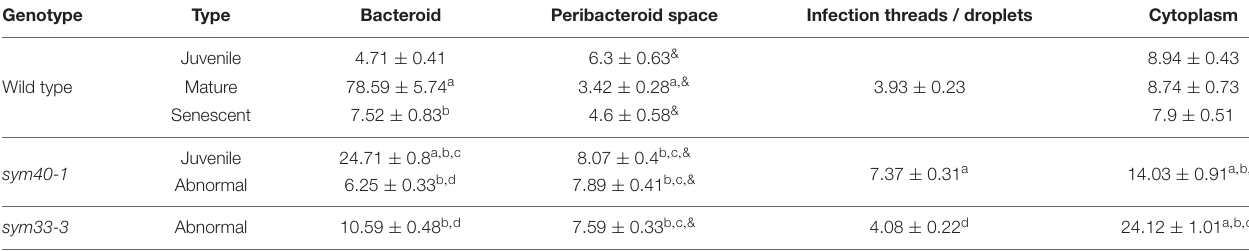
FIGURE 4 | Immunogold localization of glutathione in symbiosomes of nodules from 2-week-old wild-type and mutant ( sym40-1 and sym33-3 ) pea ( Pisum sativum ) plants. (A–C) Wild type; (D,E) sym40-1 ; (F) sym33-3 ; (A,D) juvenile symbiosomes; (B) mature symbiosomes; (C) senescent symbiosomes; (E,F) abnormal symbiosomes. Transmission electron micrographs of 90-nm ultrathin sections labeled with goat anti-rat IgG monoclonal antibody conjugated to 10-nm-diameter colloidal gold. cw, cell wall; id, infection droplet; rb, releasing bacterium; ba, bacteroid; jba, juvenile bacteroid; sba, senescent bacteroid; * indicates several bacteroids surrounded by a common symbiosome membrane. Scale bar = 500 nm. TABLE 2 | The distribution of immunogold-labeled glutathione in regions of infected cells in pea wild-type and mutant nodules. Genotype Type Bacteroid Peribacteroid